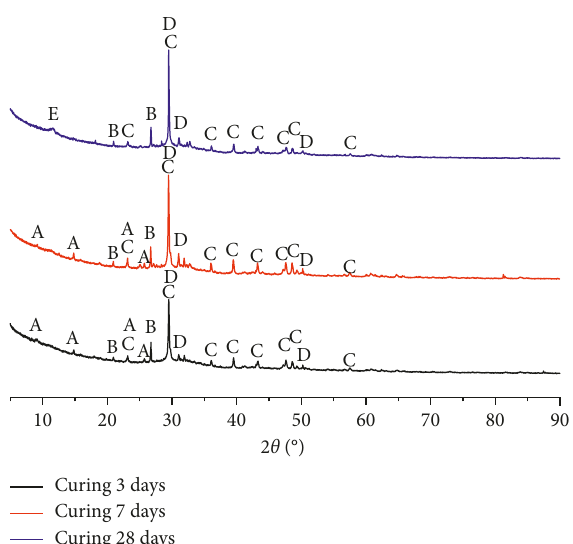
Figure 5: X-ray diffraction pattern of GP pastes with a mass concentration of 65% for curing 3d, 7 d, and 28d. (A) Ettringite; (B) feldspar; (C) calcite; (D) C-S-H gel; (E) tetracalcium aluminate hydrate.